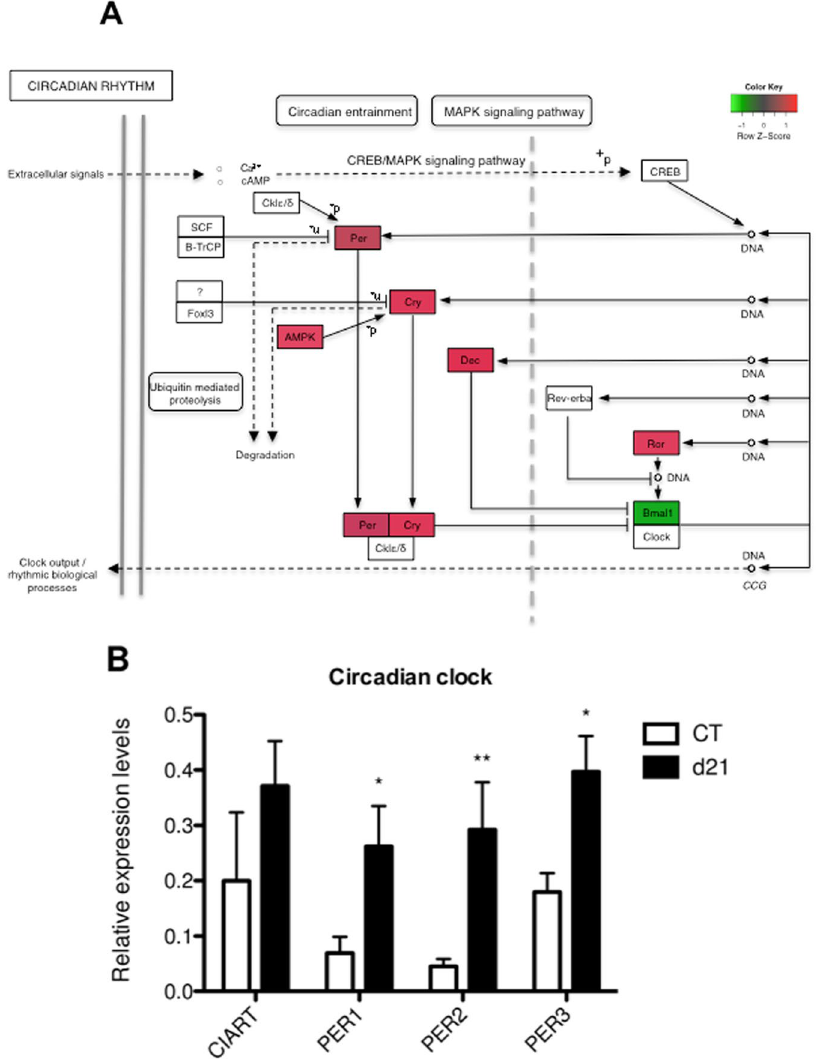
Figure 2. G . muris infection in C57BL/6 WT mice has an impact on the circadian clock. ( A ) Kyoto Encyclopedia of Genes and Genomes (KEGG) pathway for the circadian clock (©Kanehisa Laboratories) 50 . Red and green respectively indicates transcriptional up- or down-regulation in C57BL/6 WT infected mice compared to C57BL/6 WT uninfected control mice, as identified by RNA-seq. ( B ) Relative mRNA expression levels of the circadian clock associated genes Ciart, Per1, Per2 and Per3 in G . muris infected C57BL/6 WT mice as measured by qRT-PCR at day 21 post infection compared to uninfected control mice ( * p < 0.05, ** p <